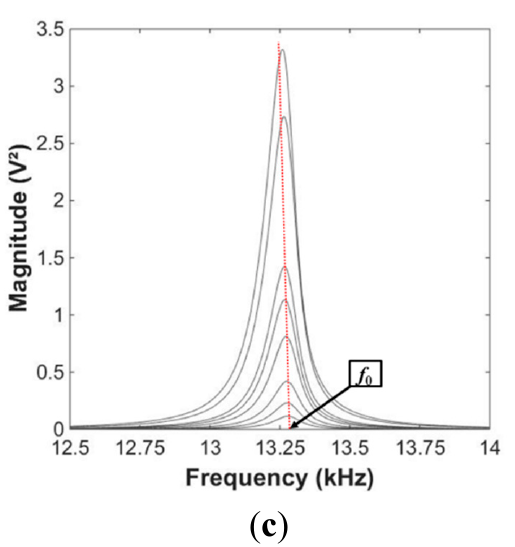
Figure 1. ( a ) Schematic diagram of the nonlinear resonance vibration method; ( b ) experimental setup; ( c ) amplitude-dependent resonant frequency shift for specimen A 1.